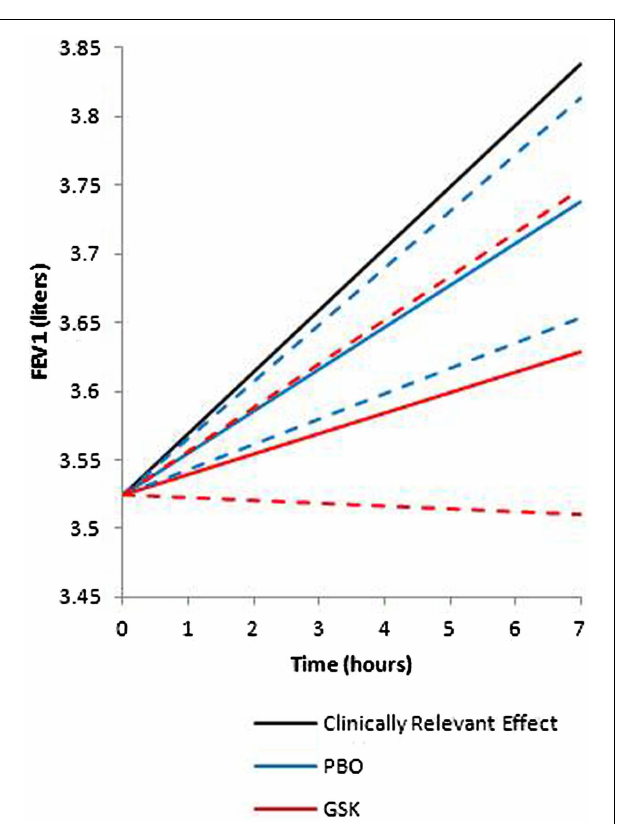
FIGURE 3 | Mean FEV1 values over time . A clinically relevant effect was defined as a mean increase in predicted FEV1 of 0.1l. For both GSK1440115 and placebo the mean FEV1 values (solid lines) over time were below what would be considered a clinically relevant.The probability the true population mean attainted this clinically relevant effect was 0.0014.The 95% credible interval (hashed lines) for the difference in FEV1 beyond placebo was ( − 0.1276, 0.0508) indicating no significant